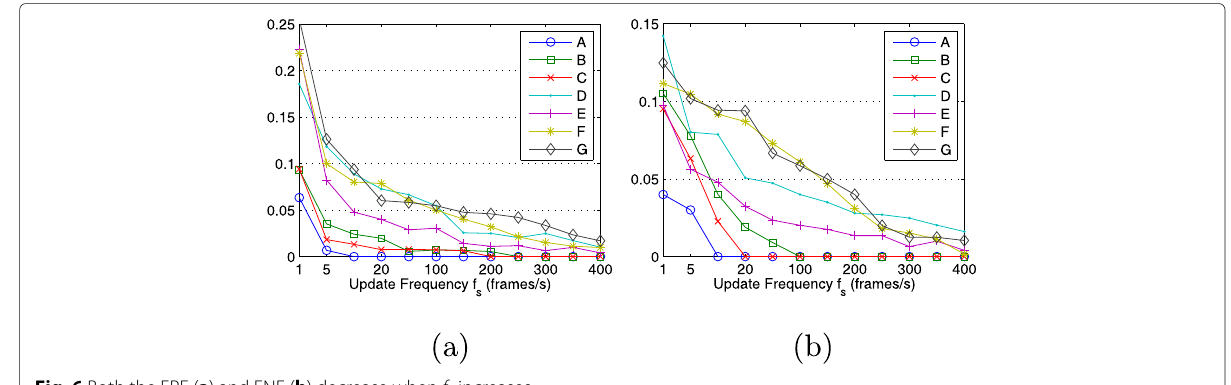
Fig. 6 Both the FPE ( a ) and FNE ( b ) decrease when f s increases